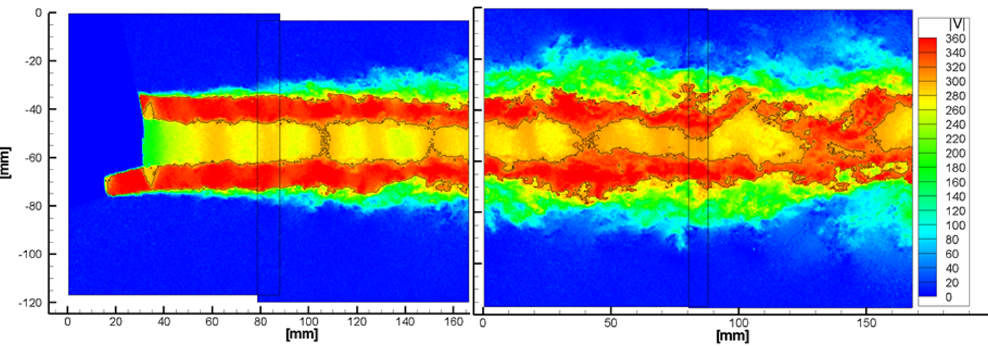
Figure 27. Instantaneous velocity flow field with Mach number M = 1 isolines for Condition 1. The jet appears to maintain its structure for several jet diameters without losing coherence. The inner jet velocity is modulated by the external flow, eventually reaching sonic speed.